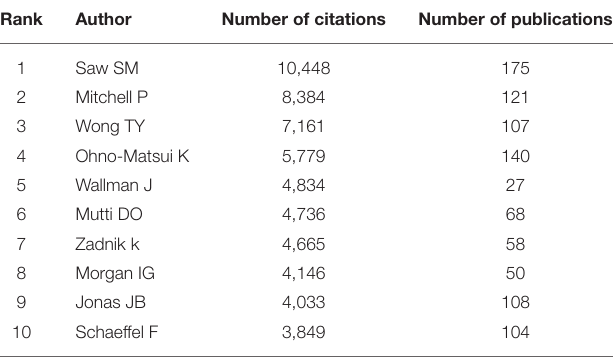
TABLE 2 | Top 10 most influential authors for myopia studies.